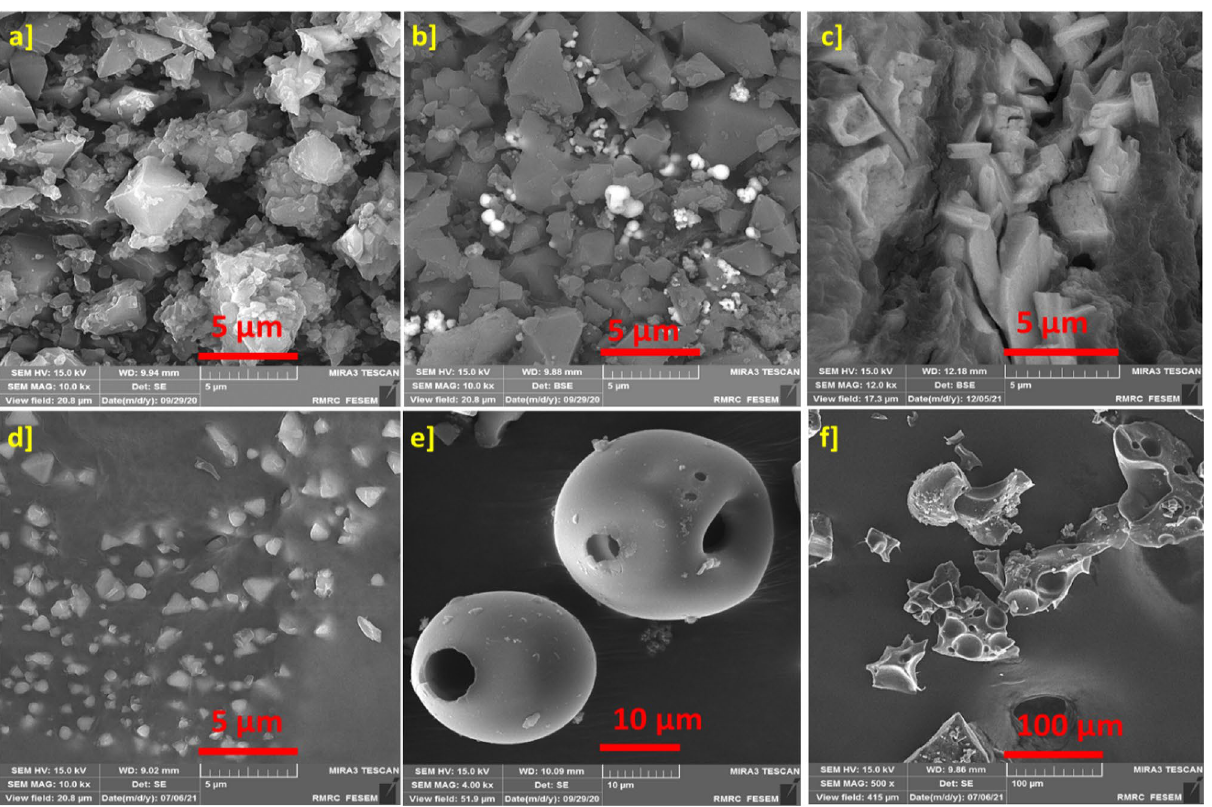
Figure 4. The FE-SEM images of various morpholines of synthesized samples: ZnTPP-NPs ( a ), ZnTPP / Cu-NPs (1) ( b ), ZnTPP /Cu-NPs (2) ( c ), ZnTPP/Cu-NPs (3) ( d ), ZnTPP/Cu-NPs-PAA-(1) ( e ) and ZnTPP/ Cu-NPs-PAA (3) ( f